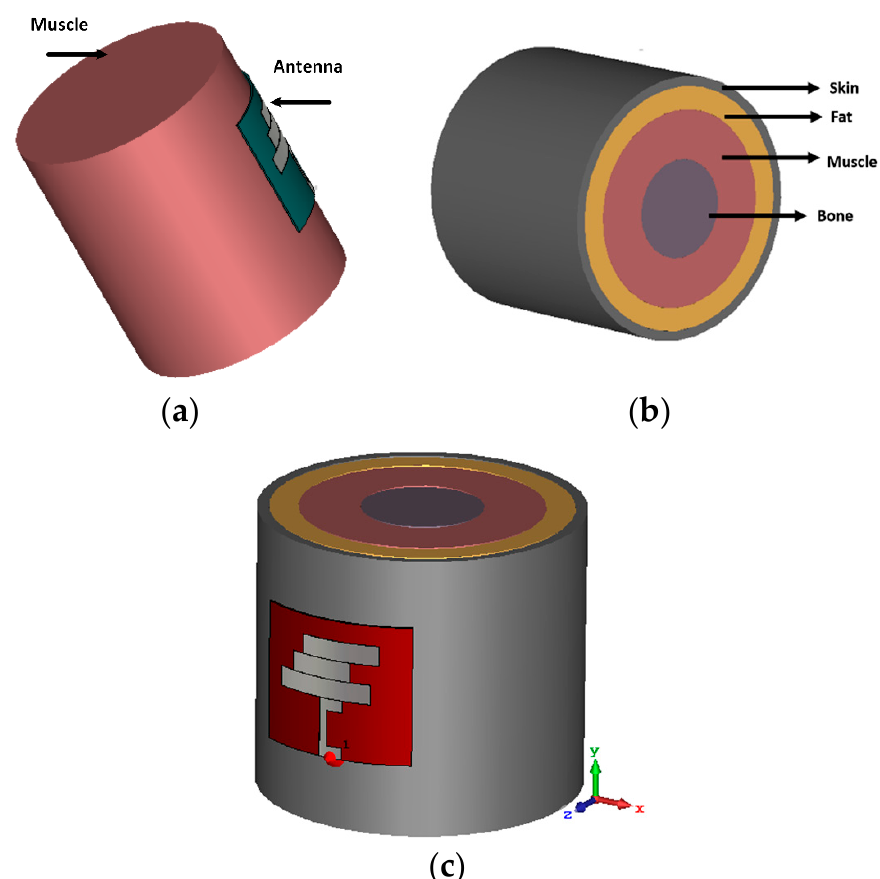
Figure 14. ( a ) Proposed antenna with homogeneous muscle phantom; ( b ) cross-view of the four-layered human tissue phantom; ( c ) antenna with human tissue.